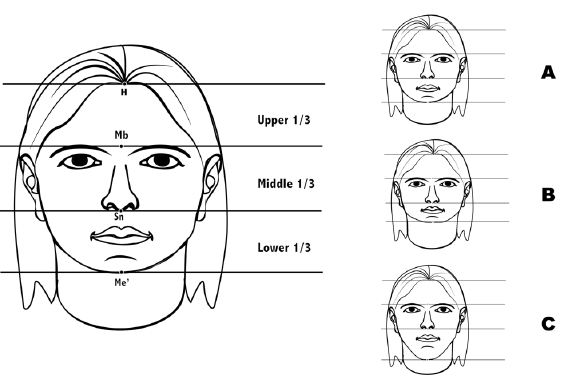
Figure 1. Facial thirds. Upper third (hairline to midbrow), middle third (midbrow to subnasale) and lower third (subnasale to soft tissue menton). ( A ) = equal facial thirds, ( B ) = shorter lower third, ( C ) = longer lower third.